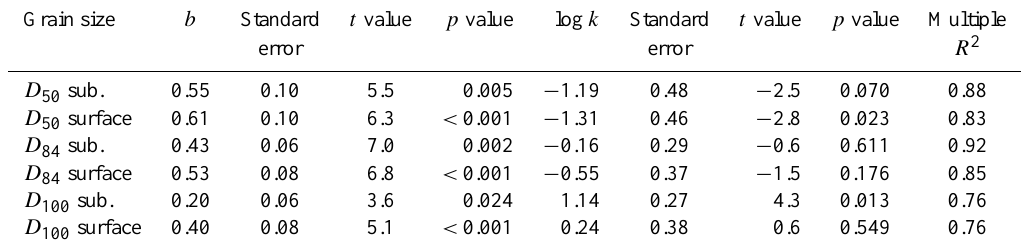
Table 1. Statistical results for regression of D = k(ω (cid:48) m ) b for Adams Creek data. D is taken as D 50 , D 84 and D 100 , both for subsurface and surface samples. Results are highly significant for the exponent b ( p value < 0.01 and high test statistic value t , except for D 100 for the surface samples), but k is poorly constrained. Grain size b Standard t value p value log